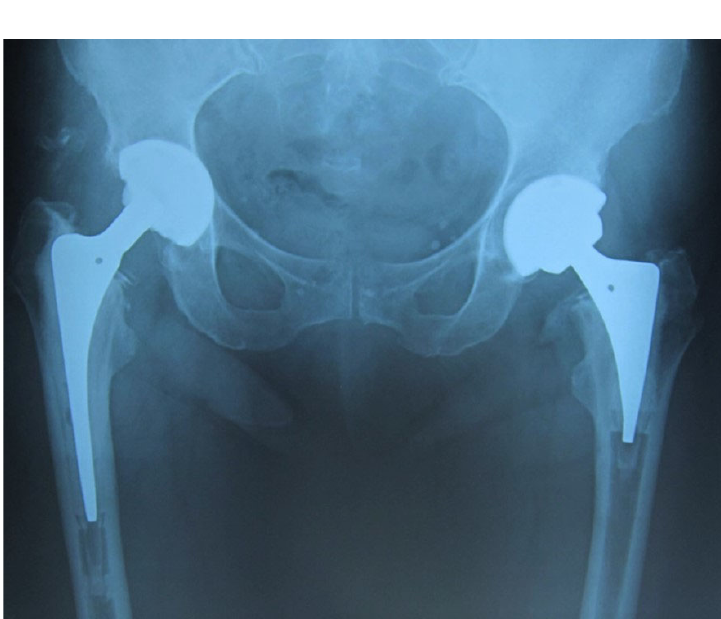
Figure 3. A patient with both conventional implant (Left), and short stem implant (Right)